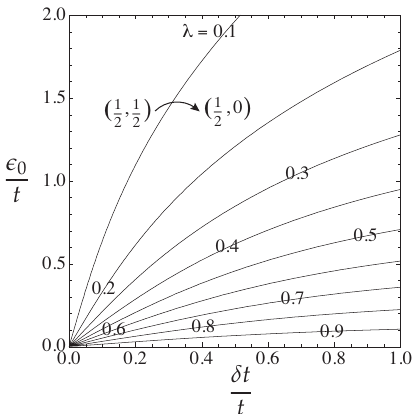
) and ( 1 , 1 ,0 ) anion orderings, as a function of the 2 2 2